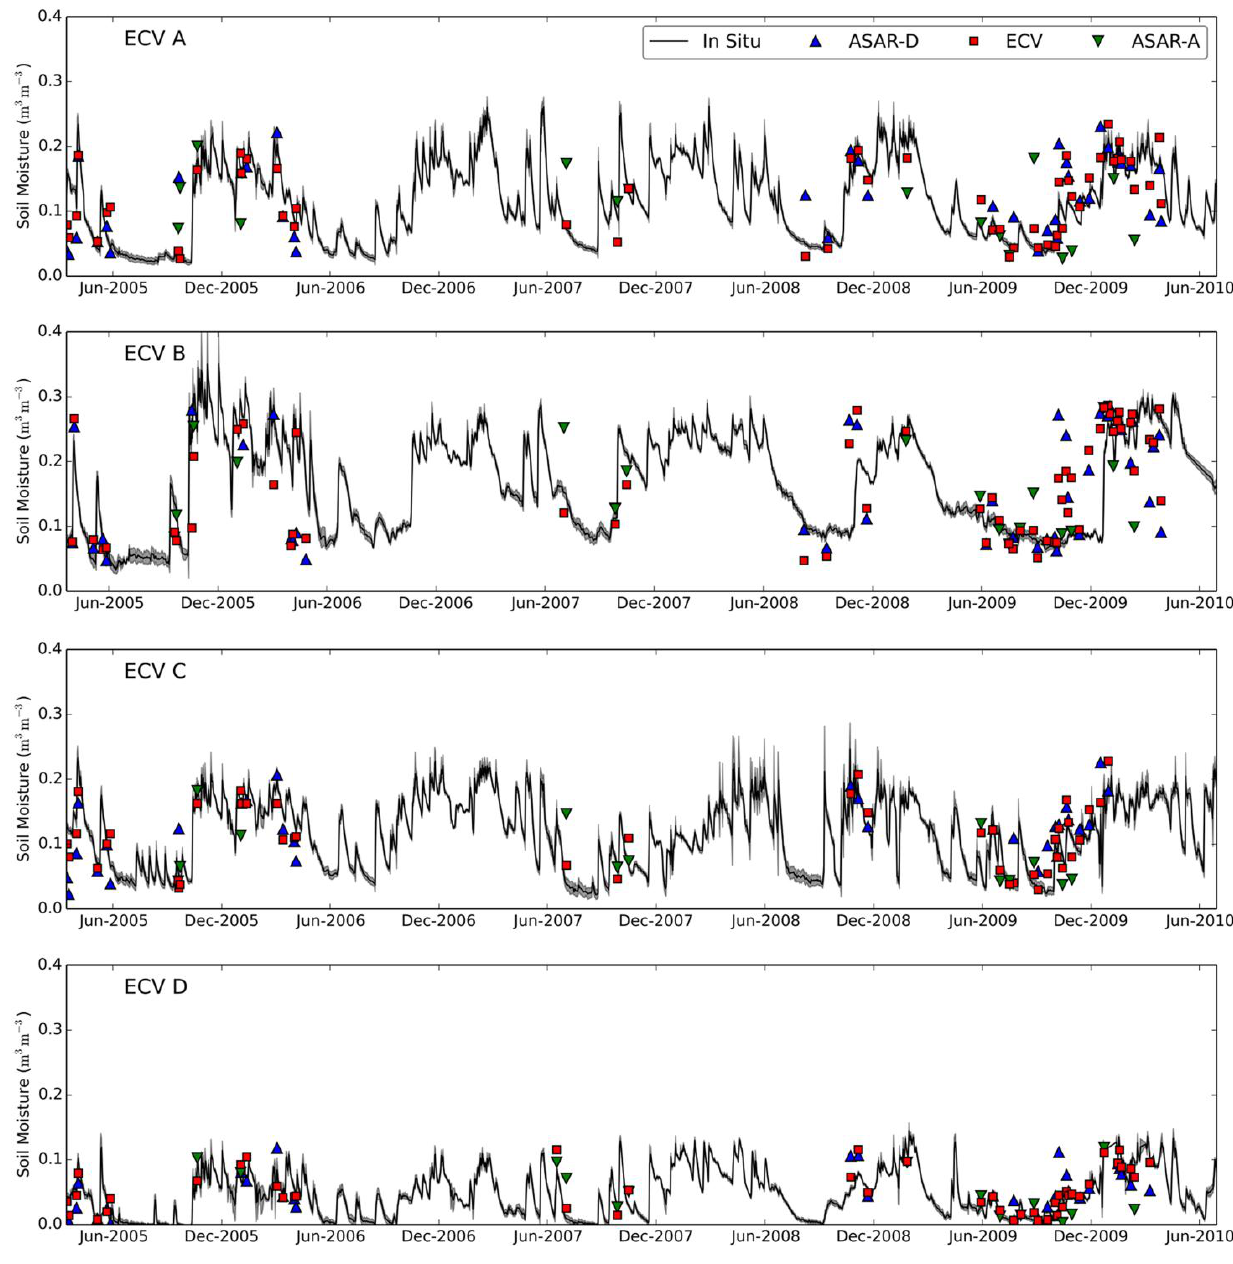
Figure 2. Time series of in situ (continuous black line), ASAR (descending (blue triangle) and ascending (green triangle) passes), and ECV (red square) soil moisture values for each Spanish ECV